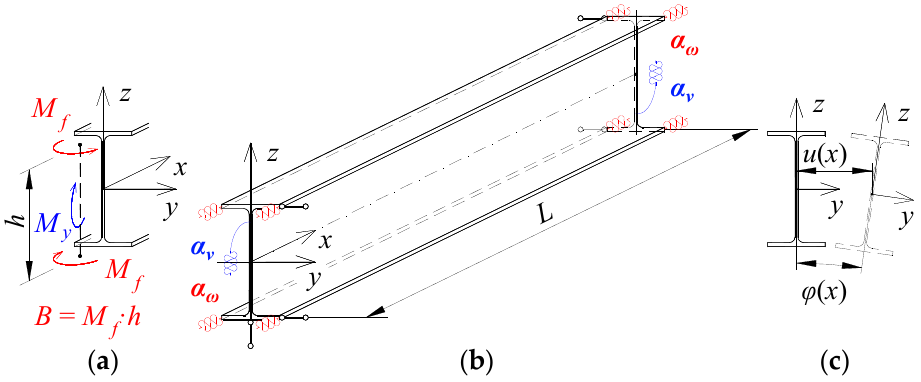
Figure 1. Static scheme of a beam: ( a ) the bimoment B and moment M y on a support, ( b ) elastic restraint against warping ( α ω ) and against rotation in the bending plane of the beam ( α ν ), ( c ) angle of twist φ ( x ) and lateral deflection u ( x ) of the beam.